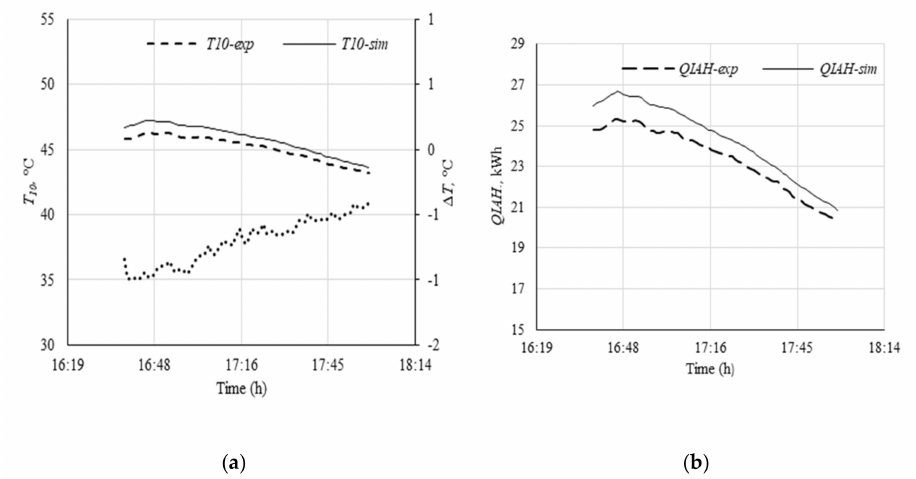
Figure 8. Heat exchanger experimental–simulated comparative, 21/August/2020. ( a ) T 10 ; ( b ) QIAH